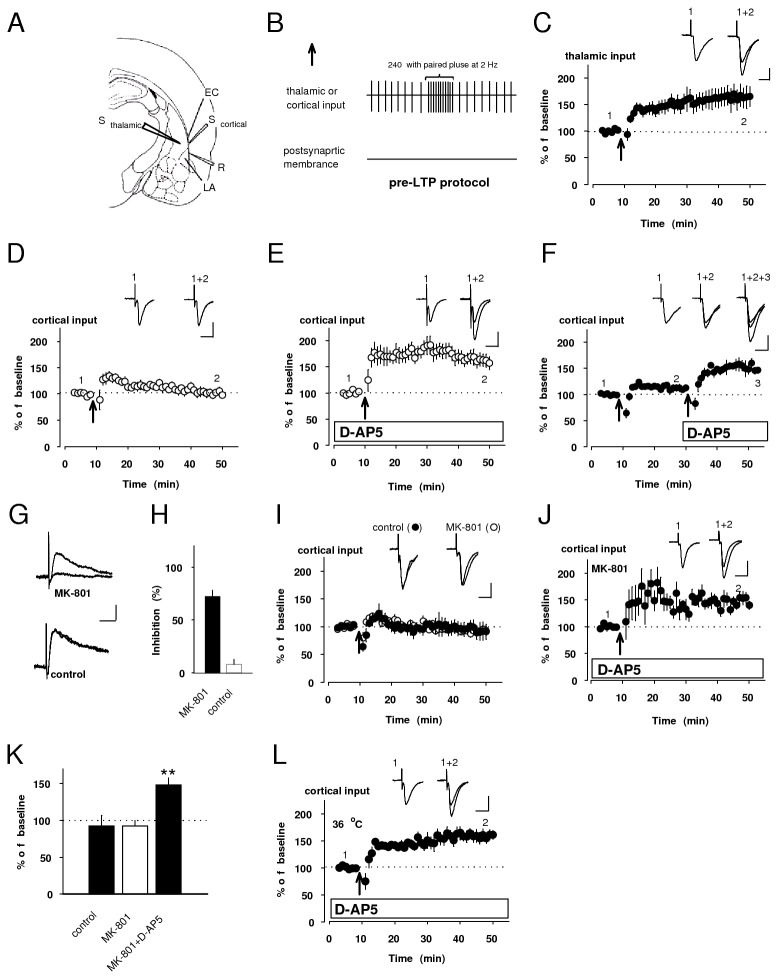
LTP in cortical input could be induced by presynaptic NMDAR blockage.
A, Schematic representation of the slice preparation showing positions of stimulation (Scortical and Sthalamic) and recording electrode (R). Scortical and Sthalamic were positioned to activate cortical and thalamic input, respectively. EC: external capsule. LA: the lateral nucleus of amygdala. B, A diagram illustrating the pre-LTP protocol: low-frequency stimulation of either thalamic or cortical input at holding potential of -70 mV. Detailed pattern, 240 pluses (2-Hz frequency) consisting of paired pulse stimulation (50 ms interval) is shown above the sign. C, EPSC in thalamic input was potentiated to 163 ± 20% of baseline by delivering pre-LTP protocol at the arrow (n=7, paired t test, p<0.05 versus baseline). D, The same protocol failed to produce LTP in cortical input (101 ± 6% of baseline, n=8, paired t test, p=0.86 versus baseline). E, However, it succeed to induce LTP with the addition of D-AP5 (50 µM) to the external solution (161 ± 12% of baseline, n=8, paired t test, p<0.01 versus baseline). Inserted traces (C-E) averages of 15 EPSCs recorded before (1) and 35-40 min after induction (2, arrow). F, Normalized LTP showing the effect of NMDAR on LTP induction at cortico-LA synapse. Insets: averaged EPSC recorded before (1) and after first (2, left arrow) and second inductions (3, right arrow). Scale bar (C-F) 50 pA, 20 ms. G, Superimposed first and last NMDAR-mediated EPSCs recorded at + 30 mV blocked by intracellular dialysis either with or without MK-801(control) in the presence of CNQX (20 µM). Scale bar: 50 pA, 50 ms. H, Summary showing the inhibition of NMDARs-mediated EPSCs with or without MK-801(control). I, Under control condition (without MK-801), EPSC in cortical input remained at 93 ± 8% of baseline (n=3, paired t test, p=0.99 versus baseline). Even after selective postsynaptic NMDAR blockade by MK-801, potentiation was still prevented (93 ± 8% of baseline, n=6, paired t test, p=0.37 versus baseline). Insets: superimposition of averaged EPSCs recorded before and after induction. J, Potentiation was readily induced under both the selective postsynaptic NMDAR blockade and bath-applied D-AP5. Insets: averaged EPSCs recorded before (1) and after (2) the induction. K, Summarized histogram showing quantification of results (I, J). L, EPSC in cortical input also potentiated to 158 ± 9% at physiological temperature, 35-36 °C (paired t test, n=5, p<0.01). Insets: average of 15 EPSCs recorded before (1) and after (2) induction (arrow). Scale bar (I, J, L) 50 pA, 20 ms. **p<0.01.